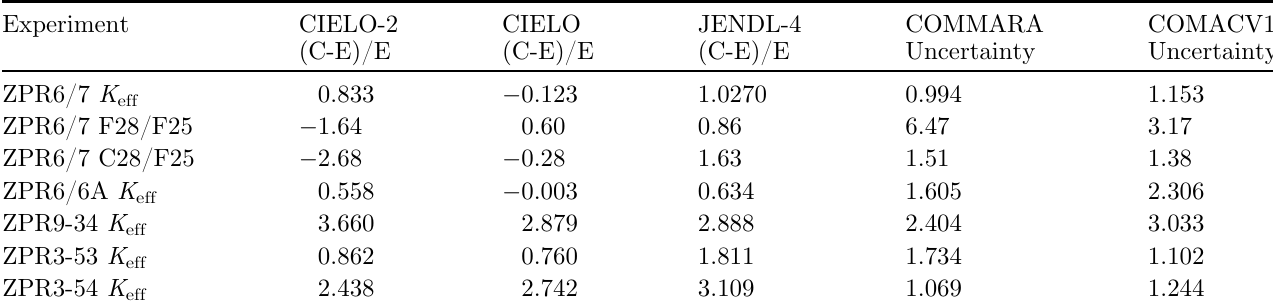
Table 3. (C-E)/E of CIELO and CIELO-2 isotopes and consistency with uncertainty of COMMARA 2.0 and COMACV1: ZPRs.